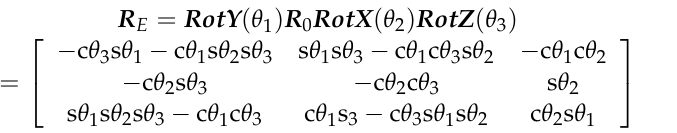
where R 0 is the initial orientation of Ω 3 with respect to Ω 0 , and RotX, RotY, and RotZ is the rotation matrix of the rotations around different axes. c θ i and s θ i are short for the cosine and sine values of θ i